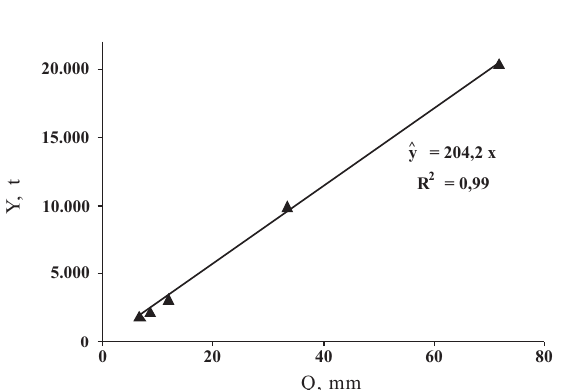
Figura 10. Relação entre o aporte de sedimento anual (Y) e o volume de escoamento superficial anual (Q) na bacia do rio Pipiripau (cenário PD), para ). os anos selecionados. anual